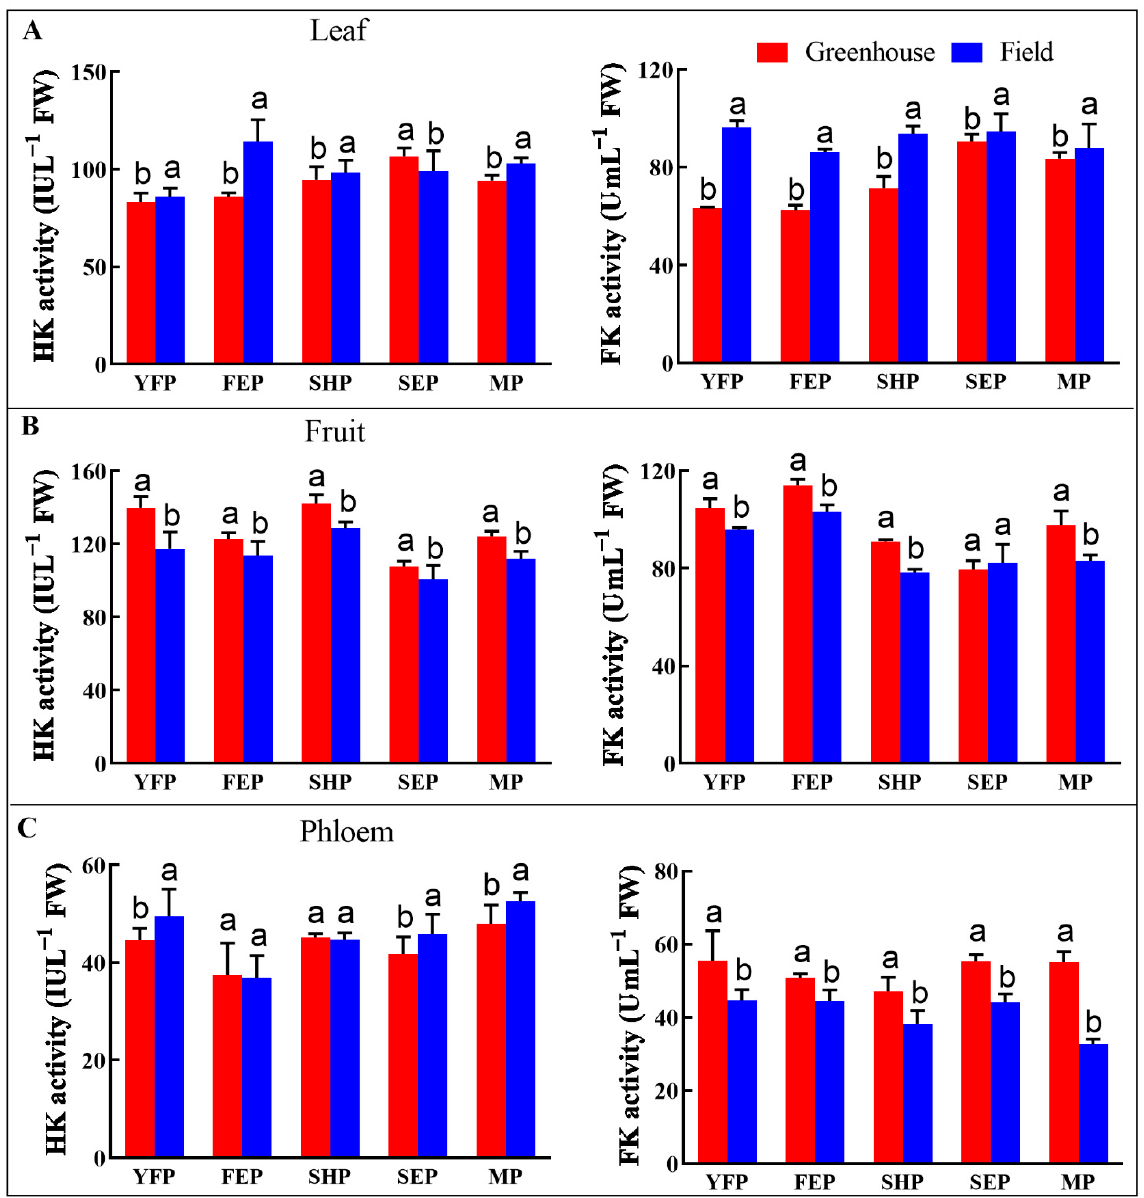
Figure 6. Activities of hexose metabolic enzymes in different parts of peach trees grown in the field and greenhouse. ( A – C ) show the activities of hexose metabolic enzymes in leaves, fruits and phloem, respectively. These enzymes include HK and FK. The data are presented as the means ± SDs from three biological replicates. Different lowercase letters indicate significant differences ( p < 0.05).